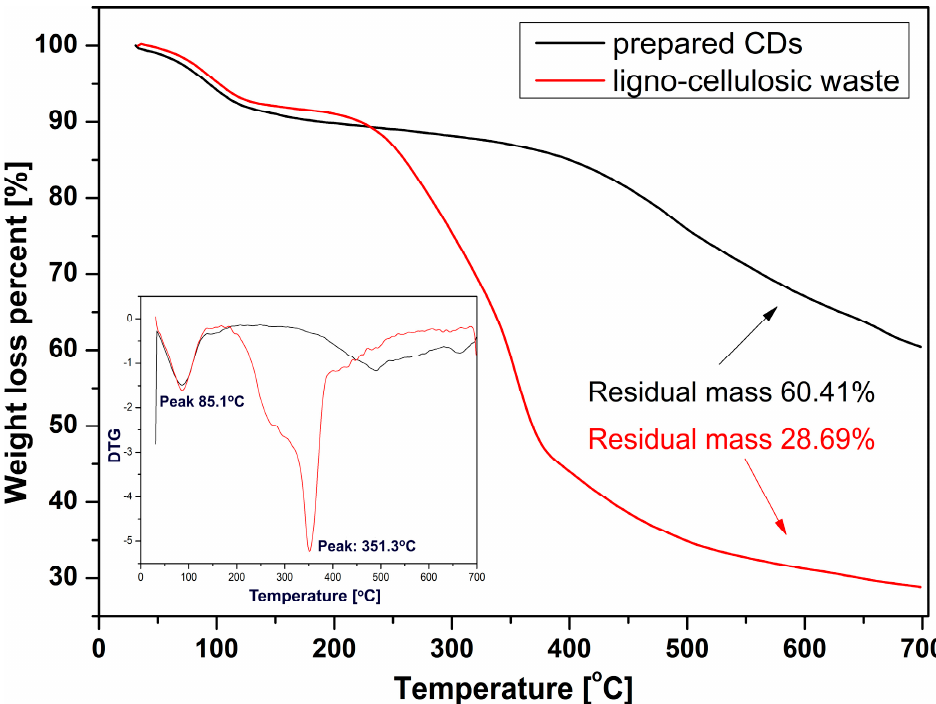
Figure 2. Mass variation recorded through thermal analysis for ligno-cellulosic waste and CDs samples.